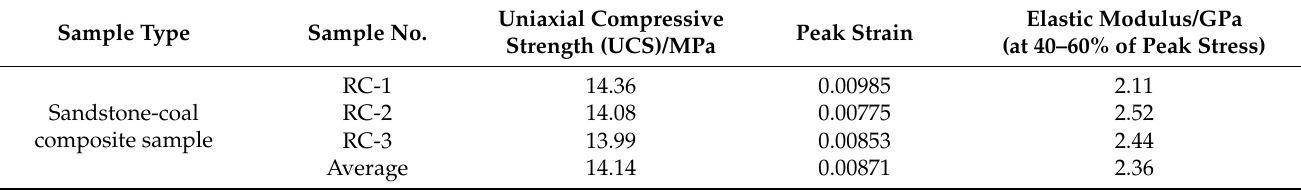
Table 1. Mechanical properties of sandstone-coal composite samples under uniaxial loading. Sample Type